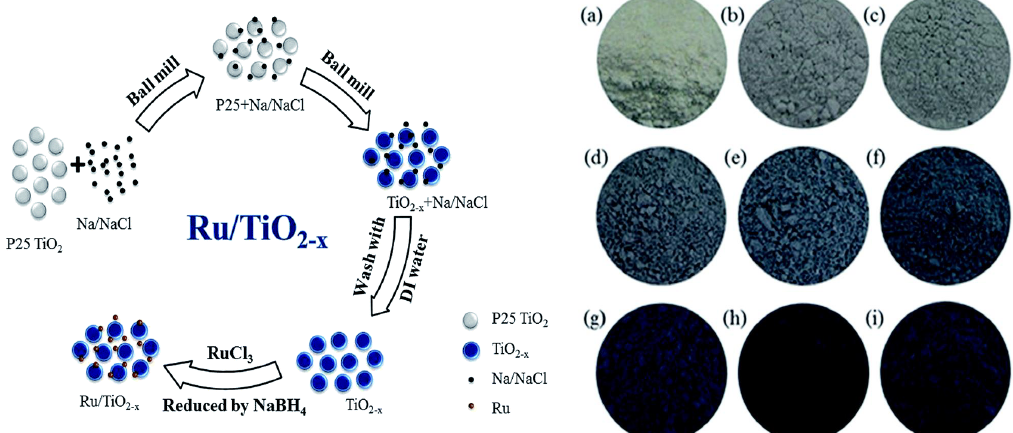
Figure 2. Scheme of the route for the preparation of Ru/TiO 2−xf . ( a – i ) Photographs of P25 nanocrystals and TiO 2−x prepared by Na/NaCl reduction corresponding to reaction times from 1 to 4 h. Reproduced from [108] . Copyright (2017), The Royal Society of Chemistry.